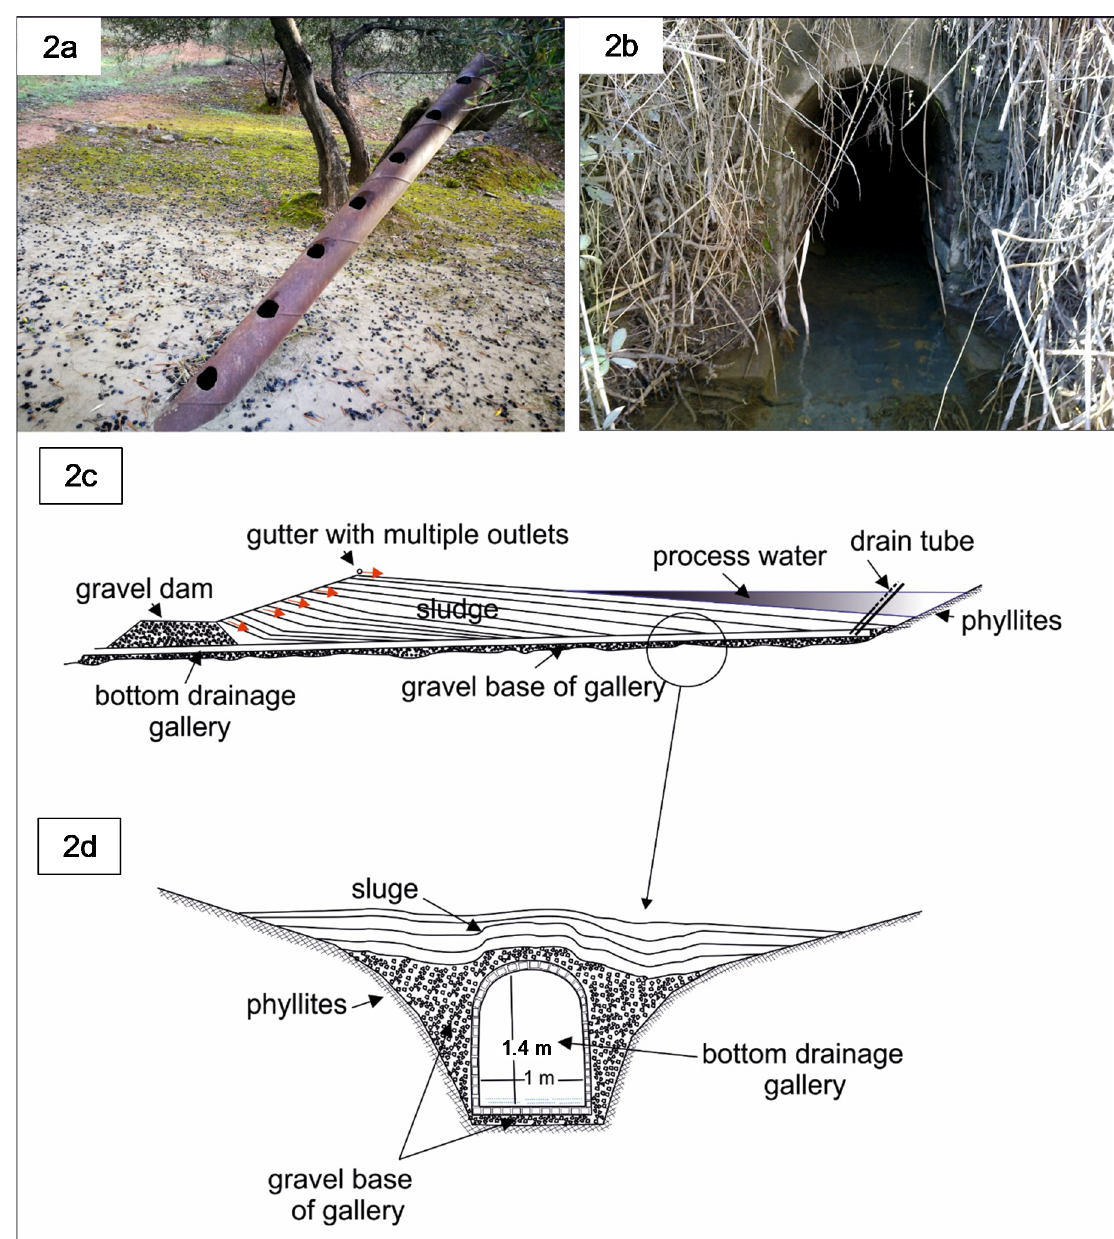
Figure 2. ( a ) Drainpipe connected to the bottom drainage gallery of the Federico dam. ( b ) Bottom discharge-type gallery of a tailings dam. ( c ) Construction diagram of the Federico flotation tailing dam. ( d ) Details of the bottom drainage gallery of the dam, which was constructed with masonry and covered with gravel.